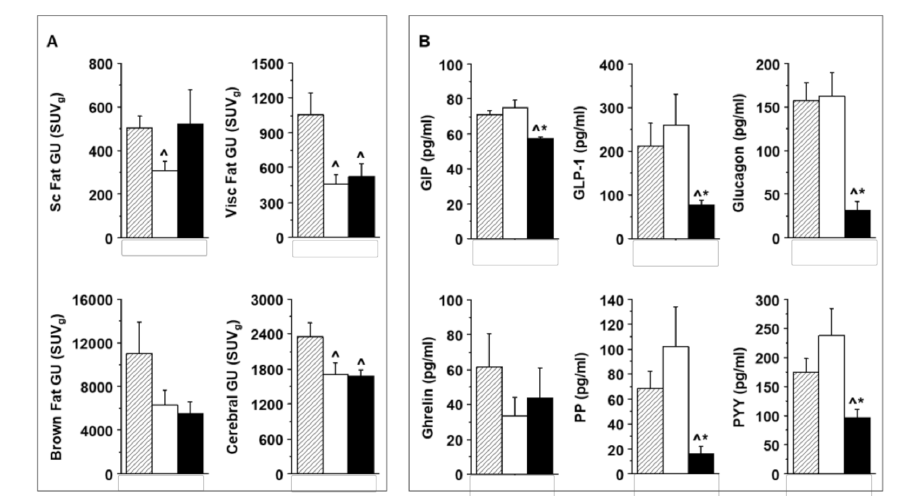
Figure 4. Significant GU rates and entero-pancreatic peptides: Integrated tissue-specific GU rates ( A ), after the oral (white bar) vs. the i.p. route (hatched bar) of glucose delivery, resulting in a reduction in adipose tissues and cerebral GU; the oral co-administration of lipids (black bar) abolished this GI effect in subcutaneous fat. The assessment of hormones involved in GI function and motility, and appetite control ( B ) demonstrated a pronounced suppressive effect of oral lipid administration. * p < 0.05 vs. oral glucose alone, ˆ p ≤ 0.05 vs. i.p.